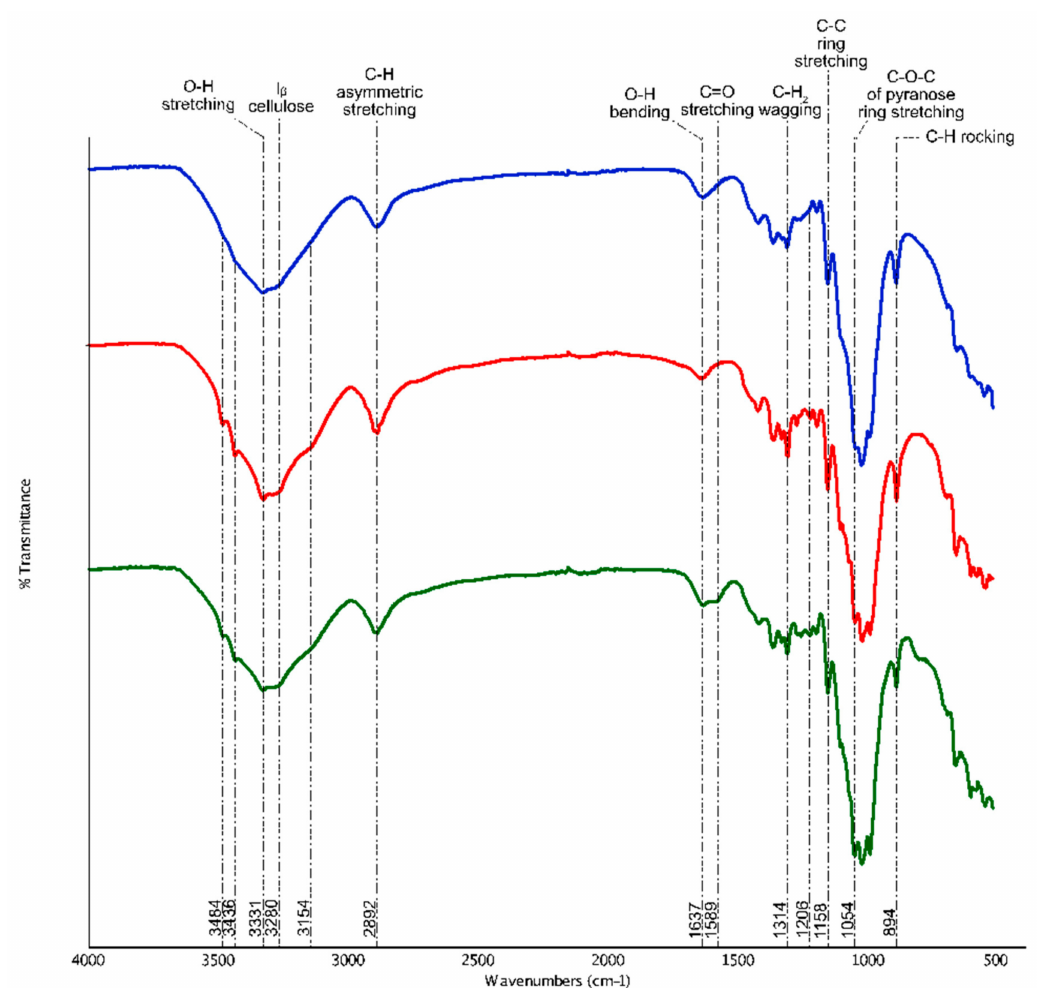
Figure 3. Attenuated total reflection Fourier transmission infrared (ATR-FTIR) spectra of CNF (blue), CNC (red), and FITC-CNC